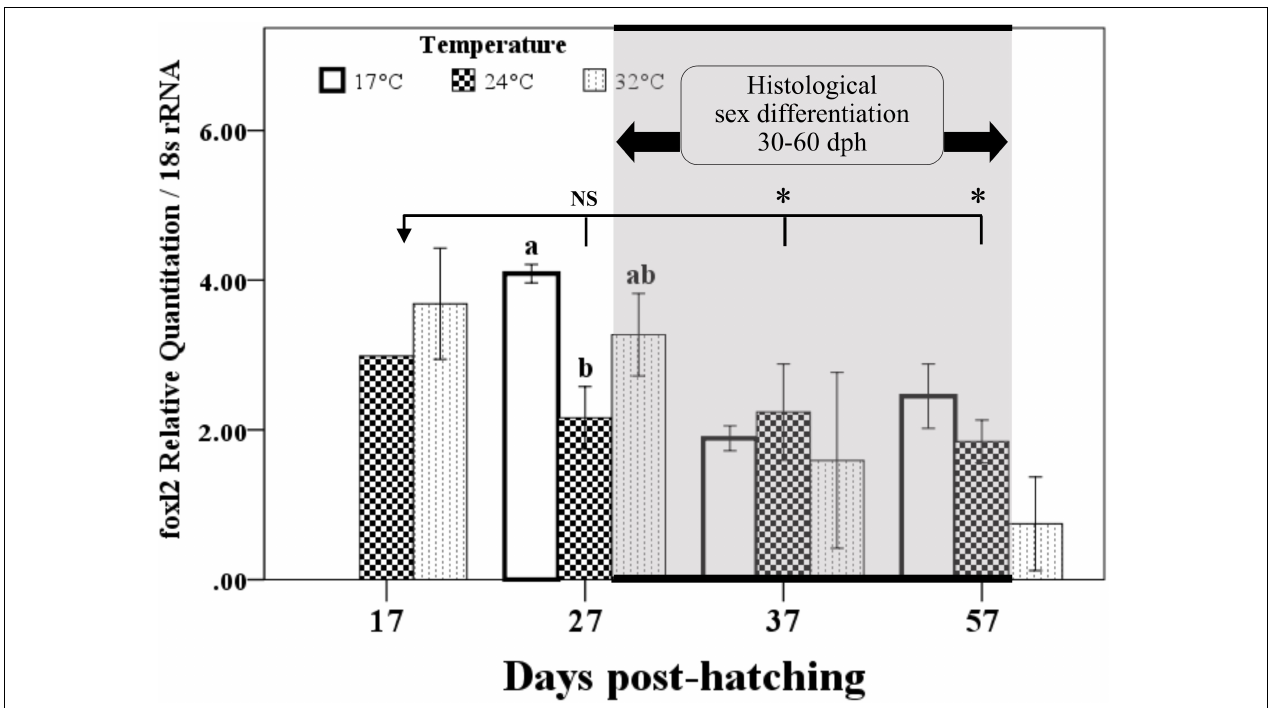
FIGURE 3 | Temporal expression of foxl2 and temperature effects in the early life stage of bluegill L. macrochirus normalized against 18S rRNA measured by real-time RT-PCR. Results are mean ± SE. Different letters in 27 days posthatching (dph) sampling point indicate significant difference among temperature treatments. Asterisks denote significant difference between 17 and 37 dph groups or 17 and 57 dph groups; NS, no significance between 17 and 27 dph group when pooling different temperature treatments together. Gray shadow area indicates that histological sex differentiation occurs between 30 to 60 dph according to our previous study (Gao et al.,